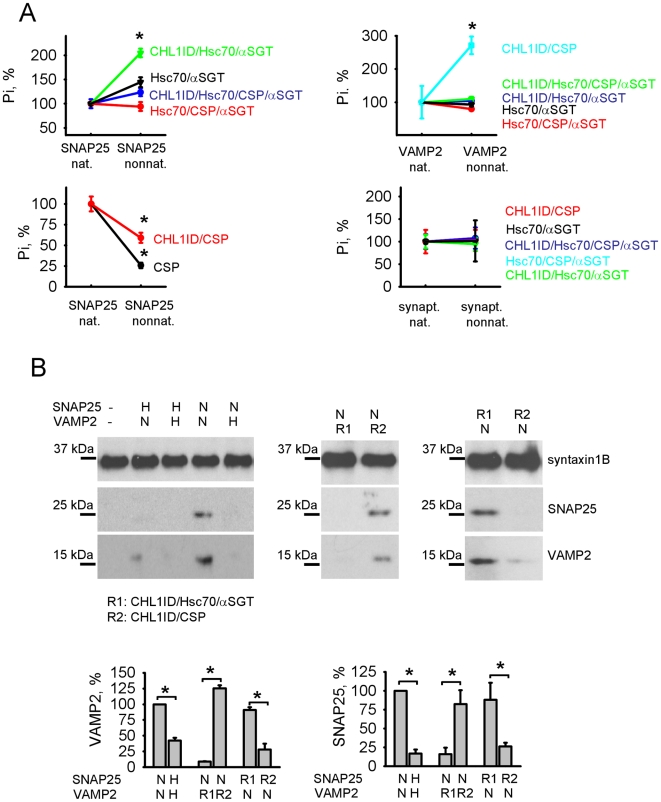
SNARE complex proteins selectively activate the chaperone activity of CHL1-containing chaperone assemblies.
A - Graphs show mean levels ± SEM of free inorganic phosphate (Pi) released from ATP (ATPase activity) by the indicated combinations of Hsc70, CSP, αSGT, and CHL1ID in response to native or heat-treated non-native SNAP25, VAMP2, or synaptophysin. The complete list of all tested combinations of CHL1ID, Hsc70, CSP, and αSGT is shown in Table S1. Note that non-native SNAP25 and VAMP2 activate ATPase activity of CHL1ID/Hsc70/αSGT and CHL1ID/CSP complexes, respectively. *p<0.05, paired t-test (compared to the ATPase activity in the presence of native proteins set to 100% (n≥6)). B - Syntaxin1B was immunoprecipitated from synaptosomes and assayed for the ability to pull down heat-treated non-native (H) or native (N) SNAP25 and VAMP2. In indicated cases, non-native proteins were preincubated with CHL1ID/Hsc70/αSGT (R1) or CHL1ID/CSP (R2) complexes. Graphs show quantitation of the binding of SNAP25 and VAMP2 to syntaxin1B ± SEM (n = 6) with the binding efficiency for both proteins in the native conformation set to 100%. Native SNAP25 and VAMP2 form a complex with syntaxin1B, while exposure to heat of at least one component inhibits the pull down efficiency. Preincubation of non-native SNAP25 with CHL1ID/Hsc70/αSGT and non-native VAMP2 with CHL1ID/CSP complexes increases the efficiency of the SNARE complex assembly. *p<0.05, paired t-test (compared as indicated).